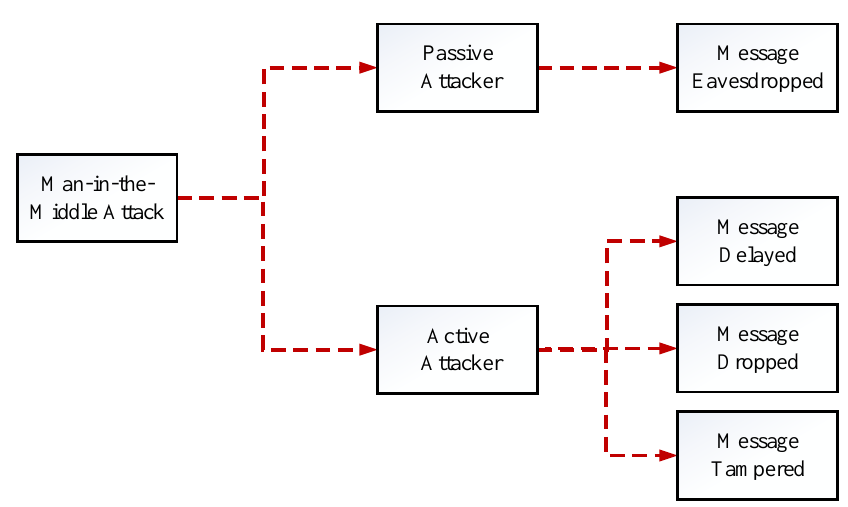
Figure 2. Man-In-The-Middle Attacks in